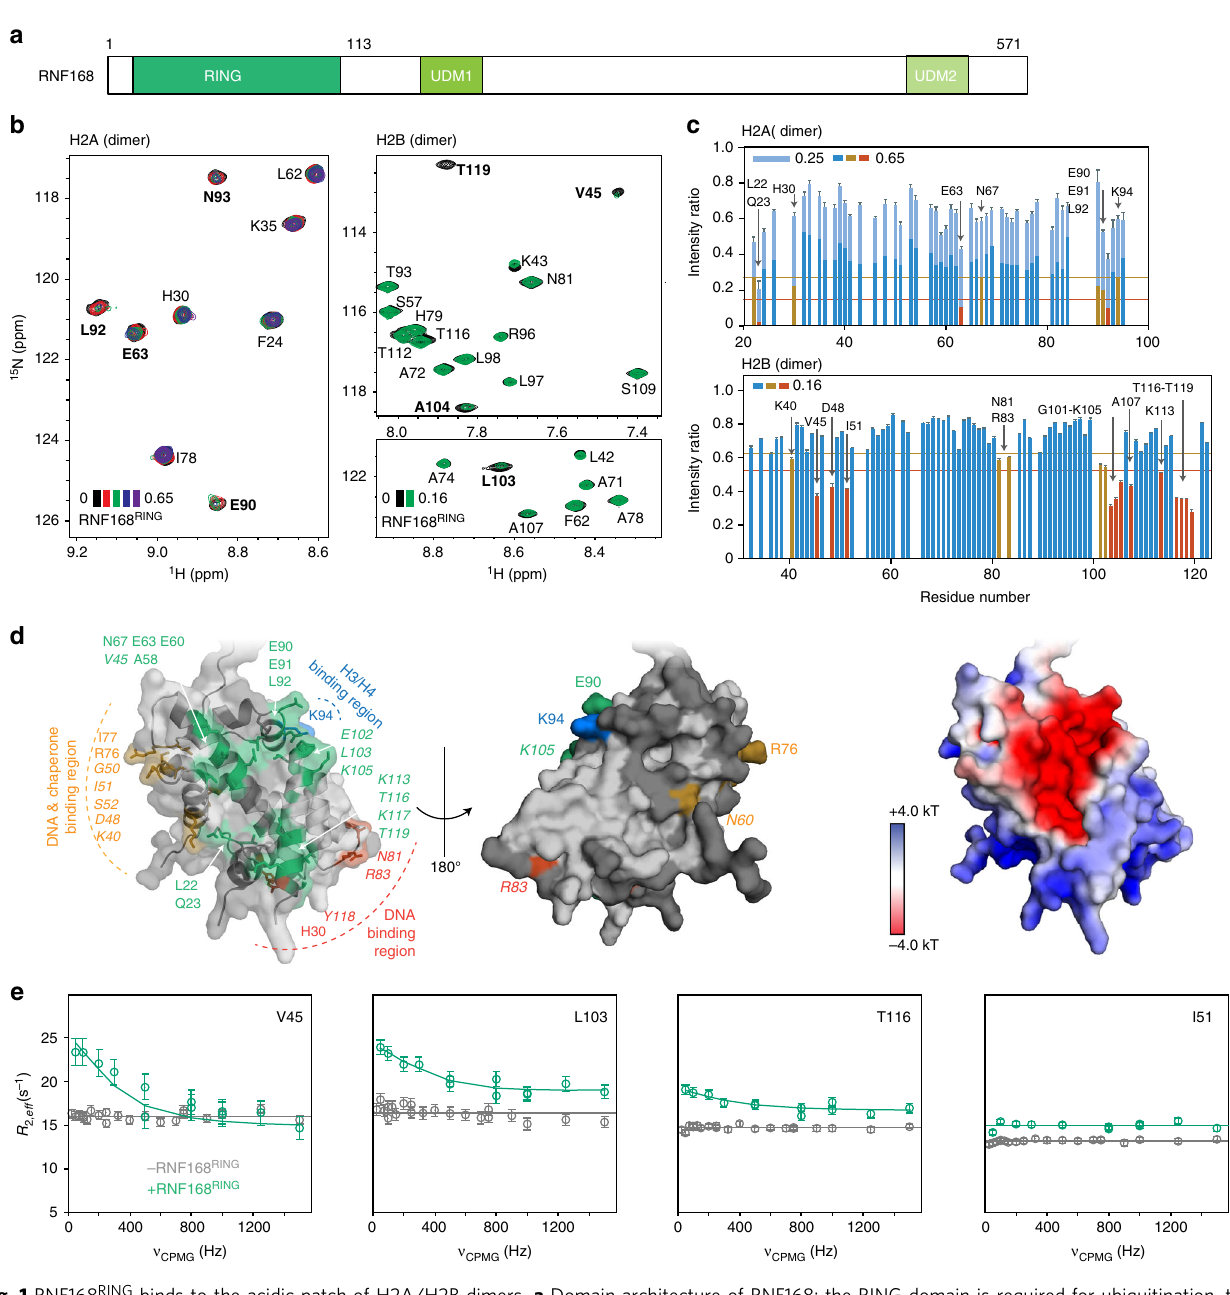
Fig. 1 RNF168 RING binds to the acidic patch of H2A/H2B dimers . a Domain architecture of RNF168: the RING domain is required for ubiquitination, the UDM1 domain mediates recruitment to the DNA damage site through interaction with ubiquitinated H1 and the UDM2 domain binds ubiquitinated H2A- K15. b Sections of the 2D 1 H- 15 N correlation spectra of H2A (left) and H2B (right) within the H2A-H2B dimer with increasing amounts of RNF168 RING added. Color coding indicated, the number refers to molar equivalents RNF168 added compared to H2A/H2B dimer. Residues strongly affected by RNF168 binding are labeled in bold. c Normalized peak intensity ratios for H2A (top) and H2B (bottom) upon addition of sub-stoichiometric amounts of RNF168 RING (indicated in Figure in molar equivalents compared to H2A/H2B dimer). Residues with intensities that are one (two) standard deviation (SD) lower than the one-sided 10% trimmed mean are color coded in yellow (red) and labeled. d Residues with signi fi cant intensity/chemical shift changes (shown as sticks) cluster predominantly in and around the H2A-H2B acidic patch (see electrostatic view on the right), with additional effects observed for the regions otherwise occluded in the context of the nucleosome (indicated in orange, blue and red). H2B residue labels in italic. Residues in light/dark grey have no signi fi cant changes/no data available. e Addition of RNF168 RING results in clear exchange-induced line broadening for H2B residues in and around the acidic patch (V45, L103, T116) but not for residues in non-speci fi c binding regions (I51) as evidenced by 15 N CPMG relaxation dispersion. Color coding indicated in the fi gure. Best- fi ts (solid lines) for the acidic patch cluster are consistent with low micromolar dissociation constants and >1 ppm chemical shift changes. Error bars are s.d. based on noise levels in panel ( c ) and based on three replicate data points in panel ( e ). Source data are provided as a Source Data fi